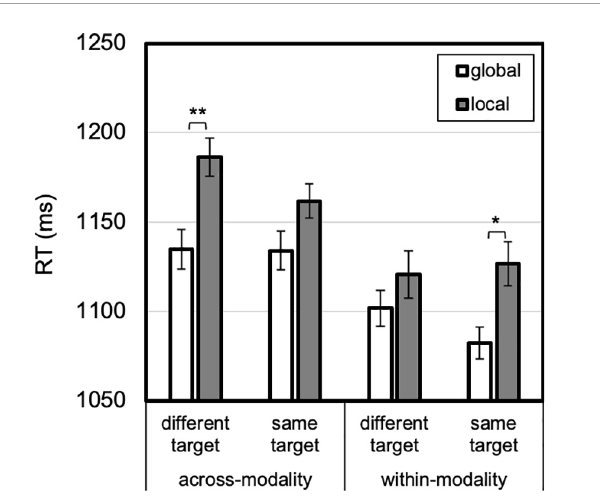
FIGURE7 Level by modality priming by target priming. A global advantage was present for different targets after modality changed and for repeated targets after modality repeated. Error bars reflect SE s adjusted for within-subjects comparisons, * p < 0.05, ** p ≤